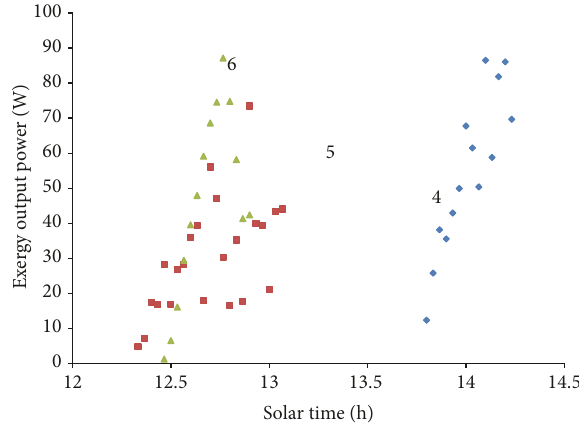
Figure 20: Least-squares fi t to the exergy loss data for experiment numbers 4, 5, and